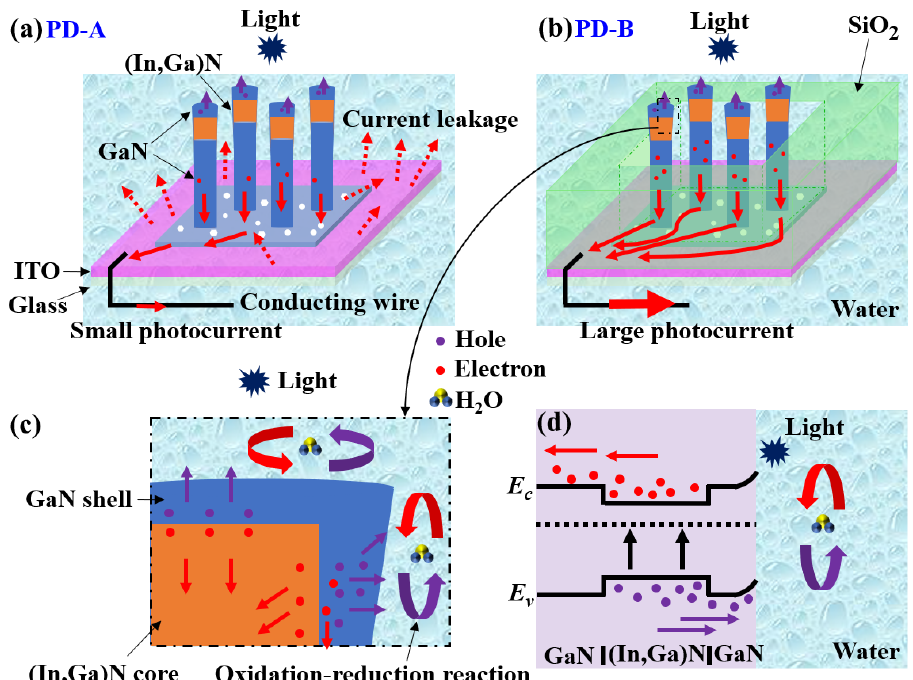
Figure 6. Schematic illustrations of ( a ) PD-A; ( b ) PD-B; ( c ) the enlarged (In,Ga)N core–shell structure, and ( d ) the corresponding energy band diagram under illuminations.